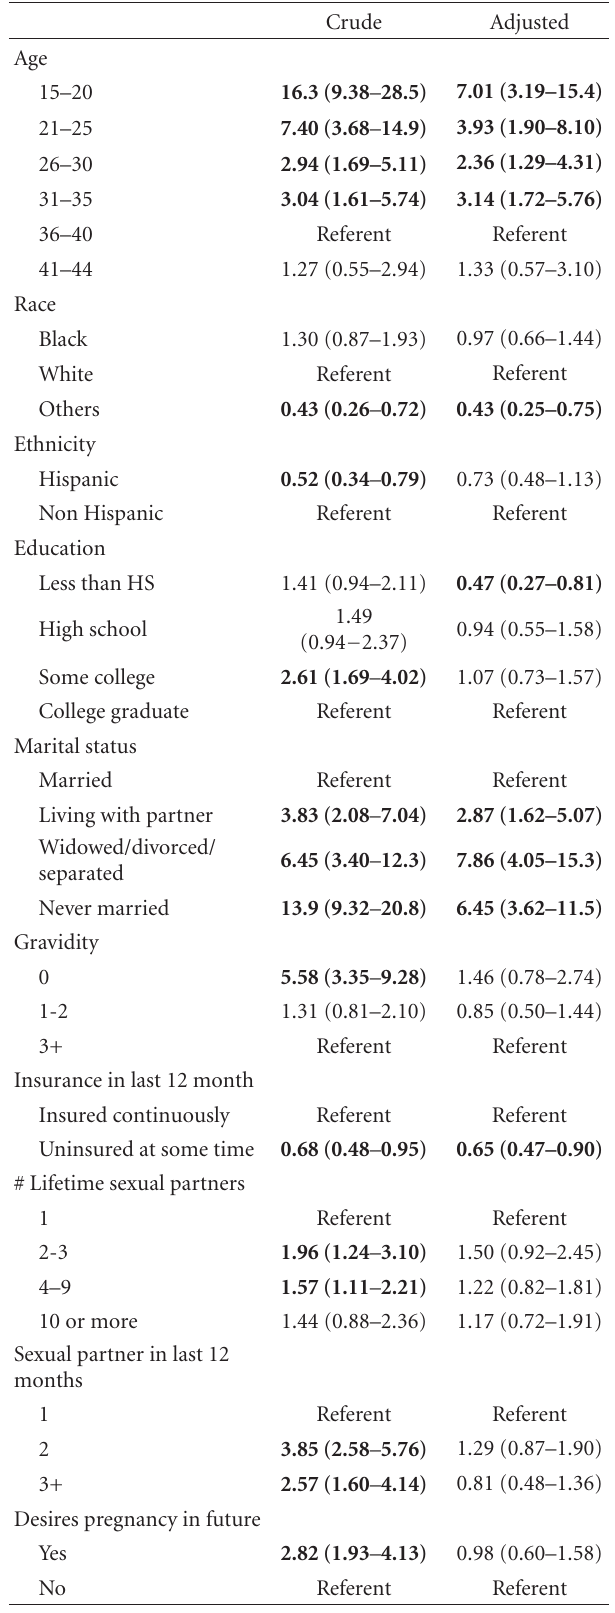
Table 3: Crude and adjusted odds ratios (and 95% confidence intervals) for dual versus non-dual-method